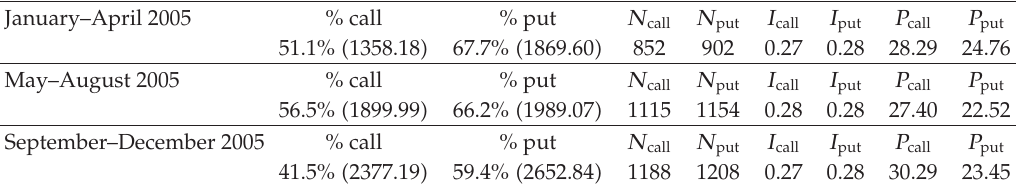
Table 2: S & P 500 option prices: at the money options (cid:2) year 2005 (cid:3) . These results were obtained using the estimates (cid:2) 4.4 (cid:3) and (cid:2) 4.5 (cid:3)